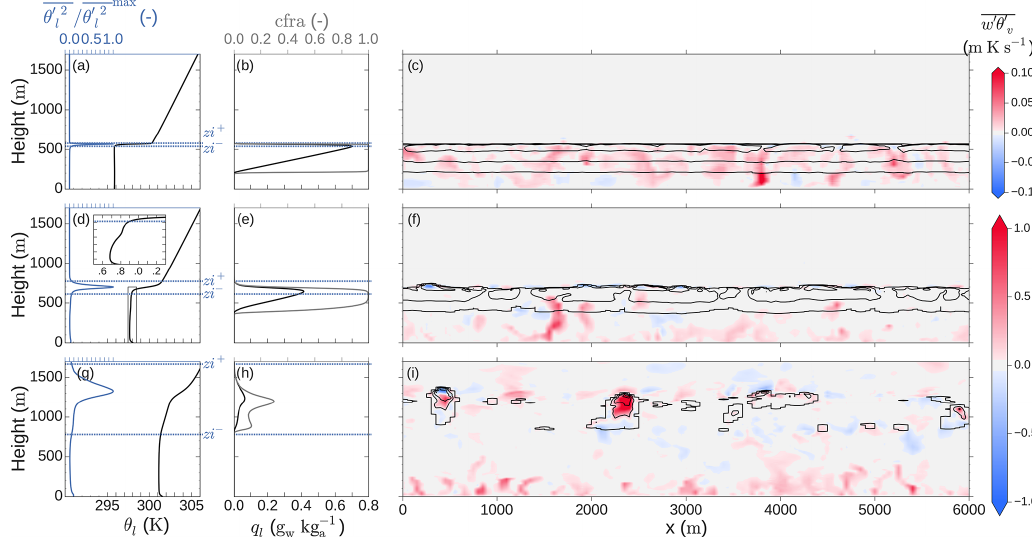
2 normalized over its maximum l